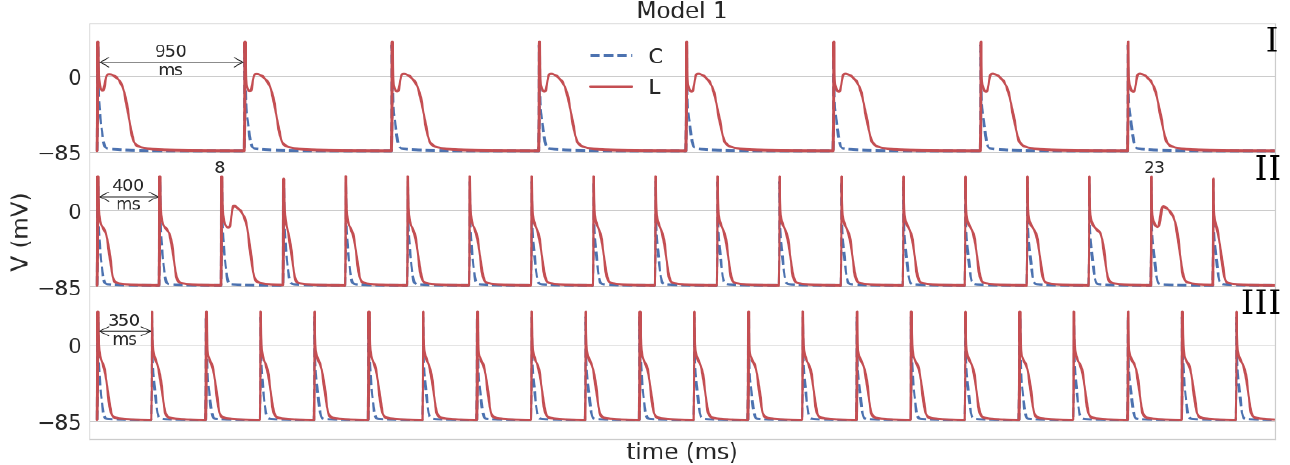
Figure 1. APs in Model 1 in the control (the dotted blue line C) and under leptin (solid red line L). For Model 1L, three main types of dynamics are shown. I (BCL = 950 ms): APs have a spike-and-dome morphology; II (BCL = 400 ms): triangular APs predominate, but there are a few APs with spike-and- dome shapes; III (BCL = 350 ms): all APs are triangular. In the control, APs have a triangular shape at all stimulation